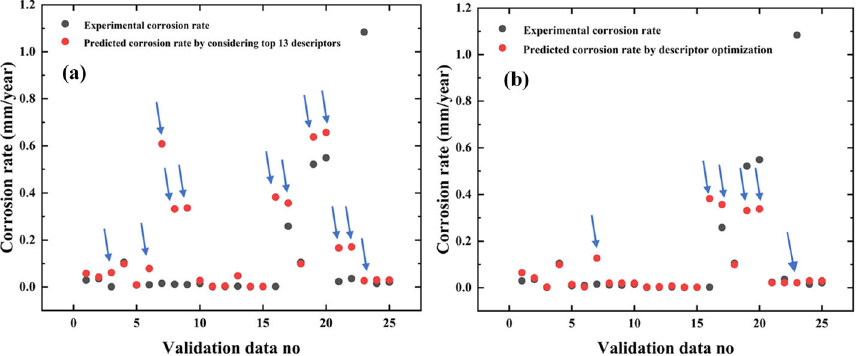
Fig. 6 Comparison between experimental and ML predicted corrosion rate. a Using top 13 features from stage 1 down selection, and b using 5 optimized features from stage 2 down selection. The bad prediction for each case is indicated by blue